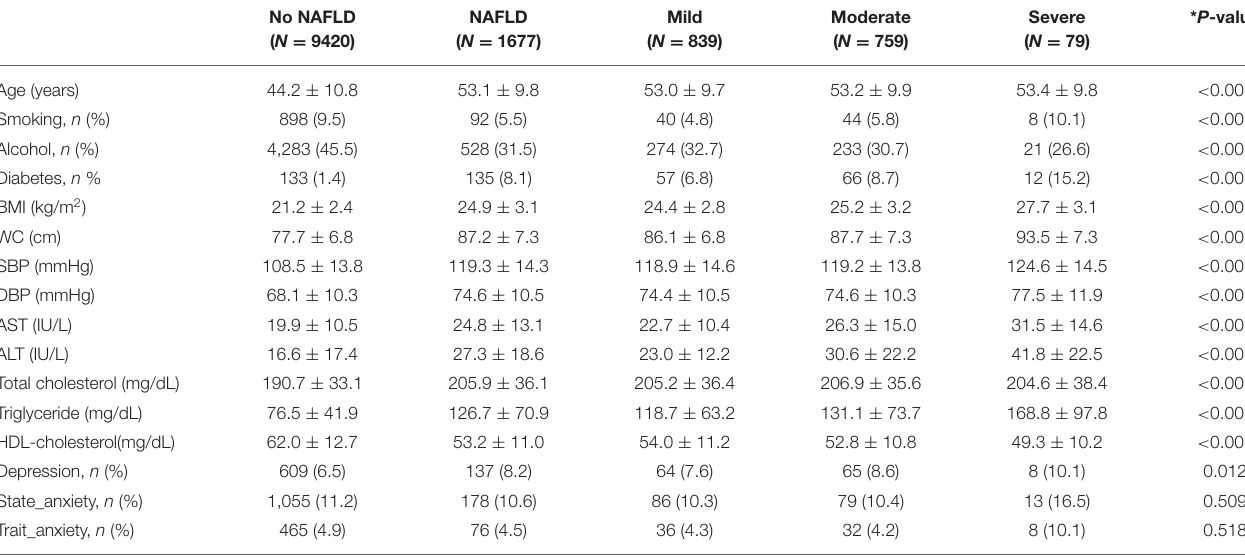
TABLE 2 | Comparison of baseline characteristics according to nonalcoholic fatty liver disease in